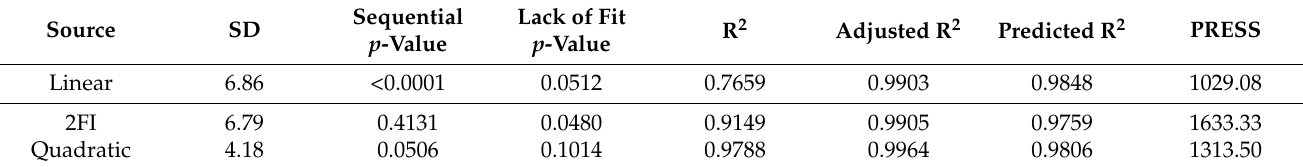
Table 3. Fit summary statistics for the globule sizes of CTD-loaded